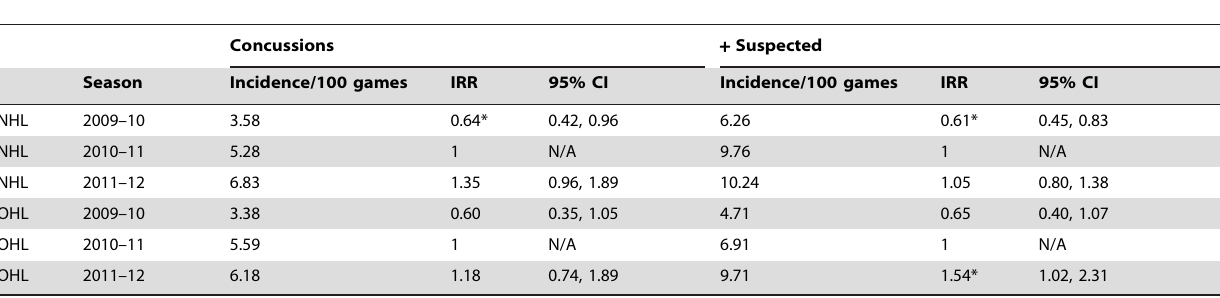
Table 2. Concussion incidence in the OHL and NHL by